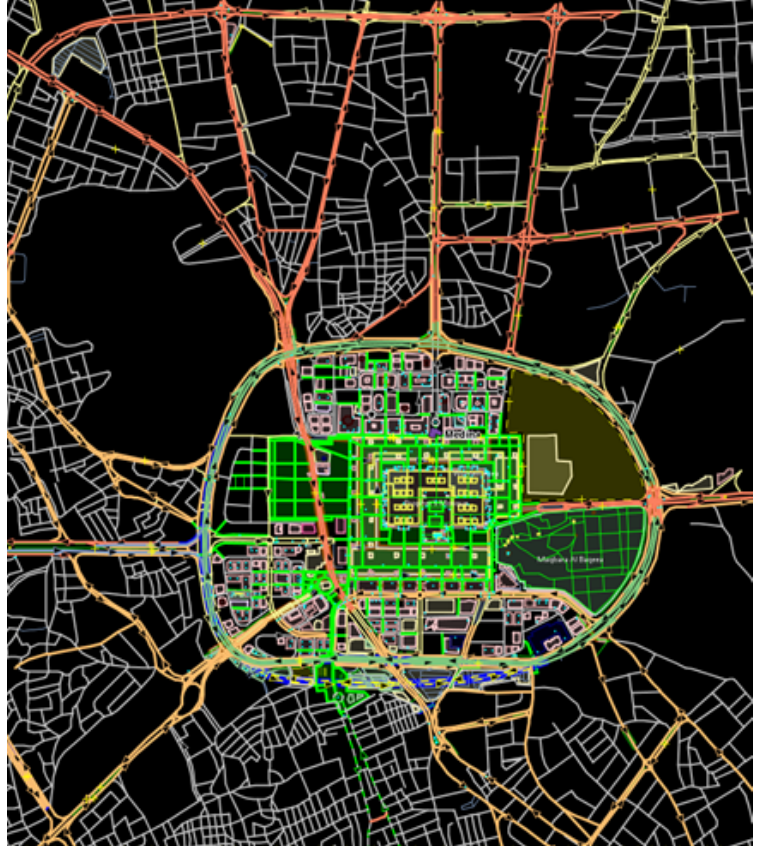
Figure 2. The imported map from OpenStreetMap of Madinah